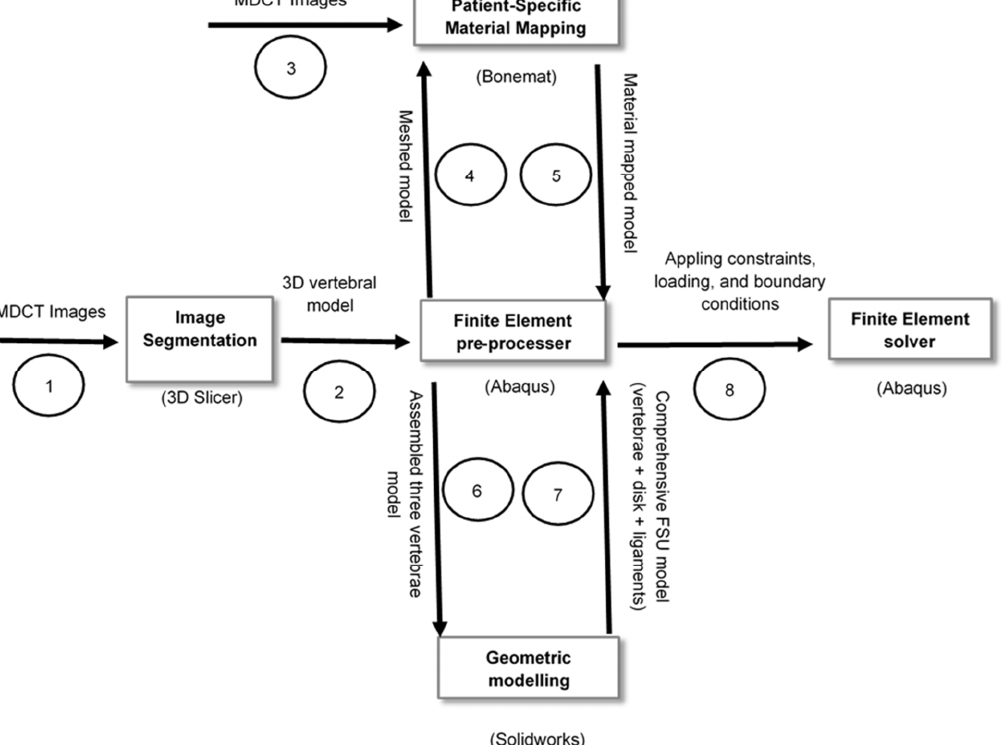
Figure 3. The flow of the segmented model between the computational tools from segmentation to model solving in the current analysis.